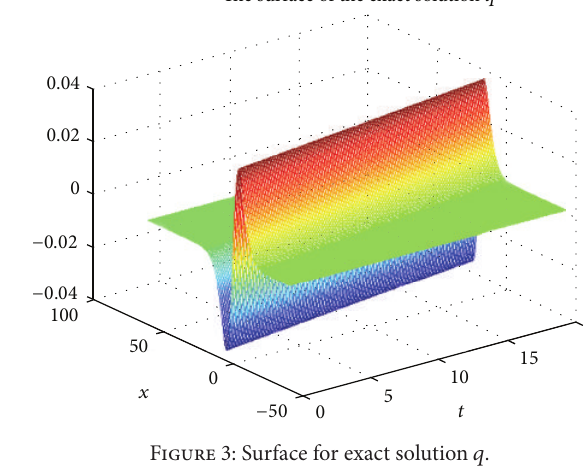
Figure 3: Surface for exact solution 𝑞 .